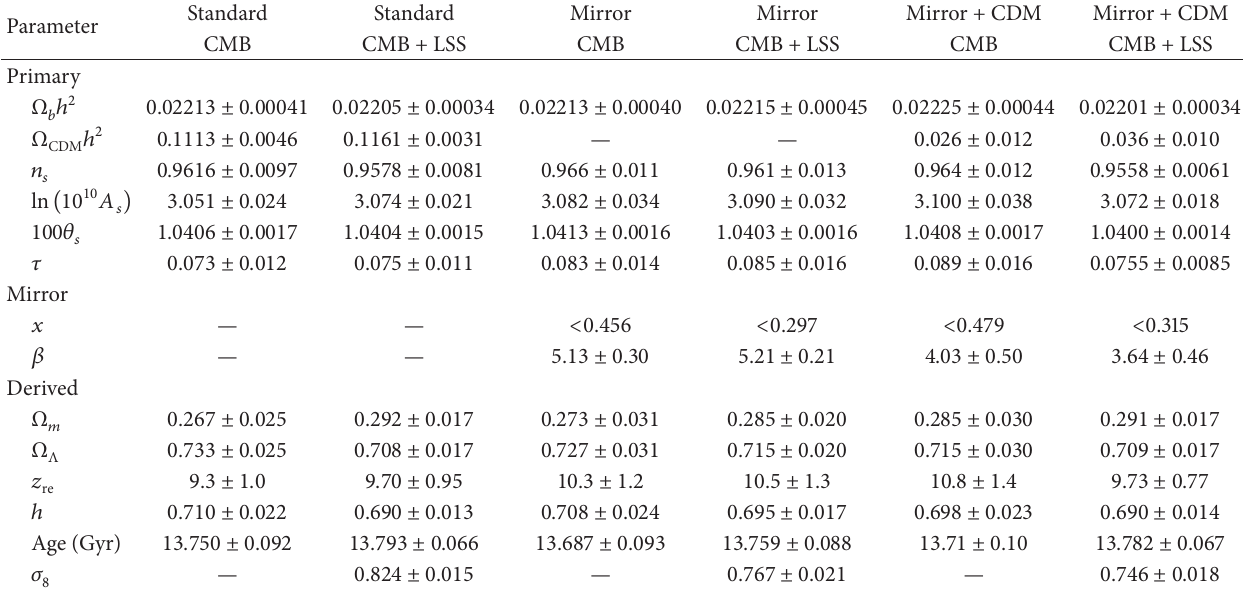
Figure 2: CMB and LSS power spectra for best-fit models with baryons and mirror matter (dashed line), or baryons, mirror matter, and cold dark matter (dotted line) obtained using both CMB and LSS datasets. For comparison we show also the standard model fit (solid line). Table 2: 1 − 𝜎 constraints on the parameters obtained using different dark matter compositions and cosmological tests. For the parameter 𝑥 we reported the upper limit computed at the 95%